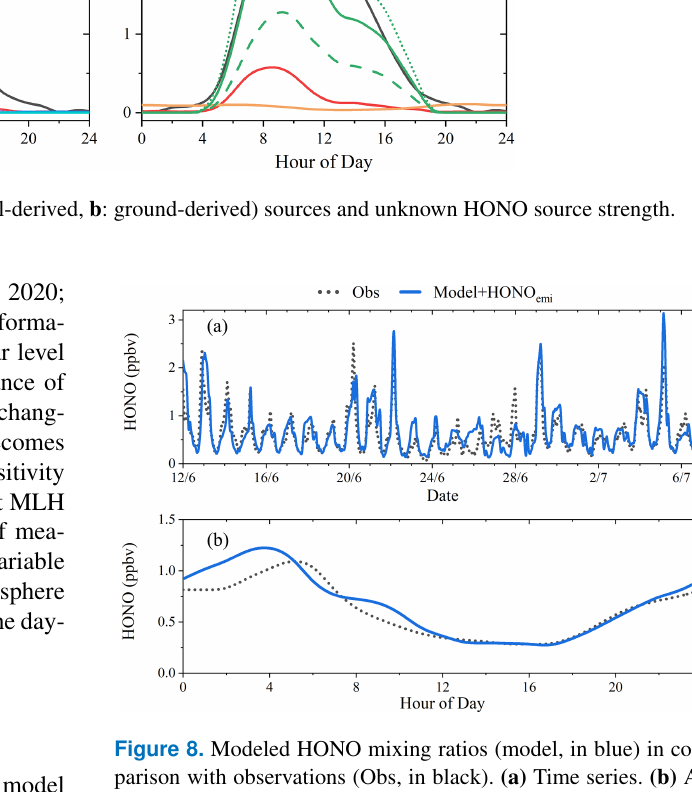
Figure 8. Modeled HONO mixing ratios (model, in blue) in com- parison with observations (Obs, in black). (a) Time series. (b) Av- erage diurnal variations. Model + HONO emi represents the sum of the modeled HONO and HONO emi